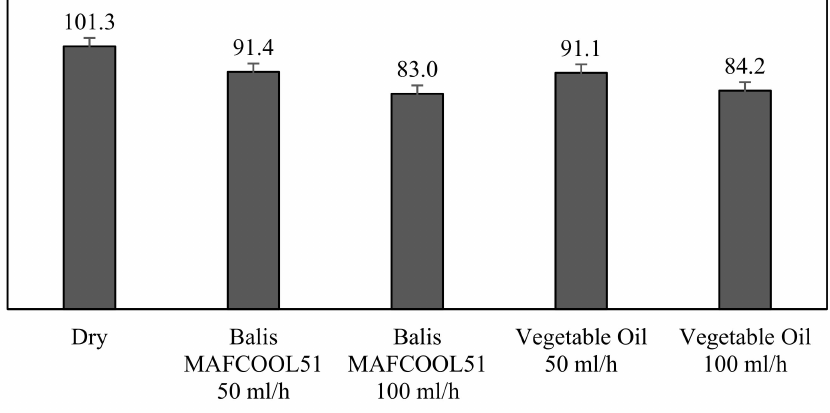
Figure 11. Average chip temperatures [(C) in each group of machining